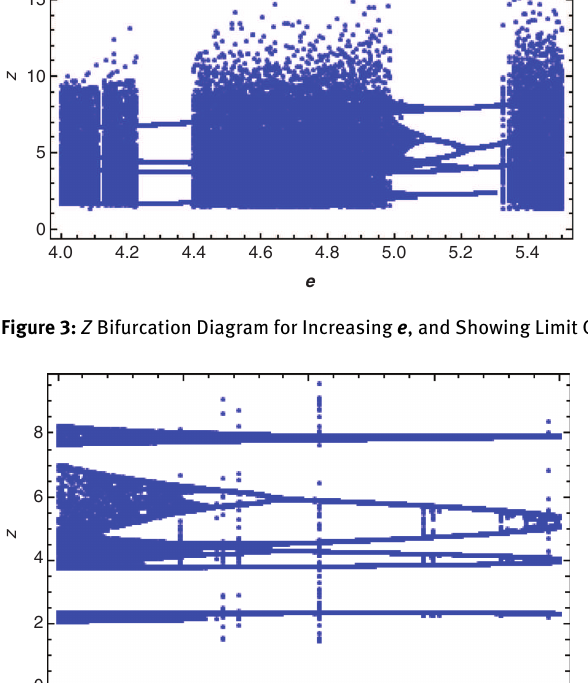
Figure 4: Zoomed in z Trajectory Diagram. This zooms into the region of Figure